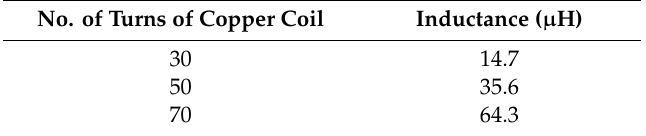
Table 1. Table showing the various sensors fabricated with their corresponding inductance values. No. of Turns of Copper